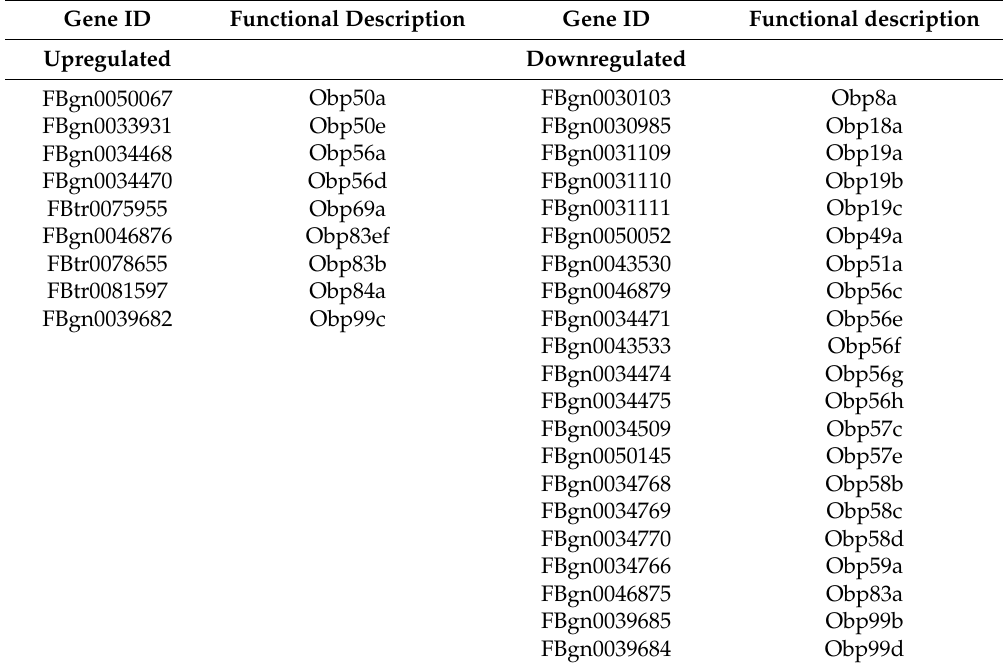
Table 3. Odorant-binding protein (Obp) genes: Down- and up-regulated after 14 days HFD treatment. Gene ID Functional Description Gene ID Functional description Upregulated